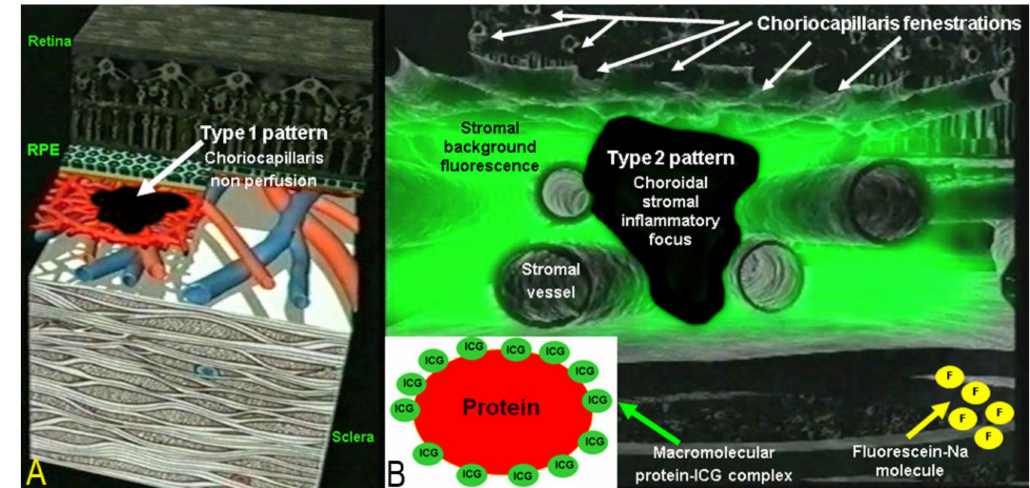
Figure 3. Indocyanine green angiography (ICGA) patterns in non-infectious choroiditis. Two main patterns have been identified in choroiditis. Pattern 1 is seen in inflammatory choriocapillaris non-perfusion ( A ). Pattern 2 is found in stromal inflammation when foci develop and impair the diffusion of the ICG-protein complex shedding from the fenestrate choriocapillaris ( B ). The ICG-protein complex is shown in the insert, which is much larger than the fluorescein molecule with a slow wash-out from the choroid.